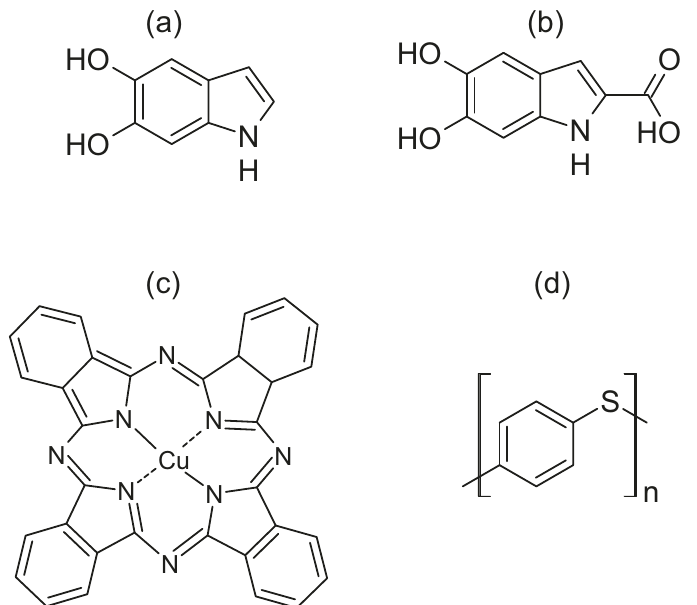
Fig. 1 Molecular structures of the organic electronic materials investigated. a 5,6-dihydroxyindole (DHI) and ( b ) 5,6-dihydroxyindole-2-carboxylic acid (DHICA), the building blocks of eumelanin. c Cu (II) phthalocyanine (Cu – Pc), and ( d ) monomer of polyphenylene sul fi de